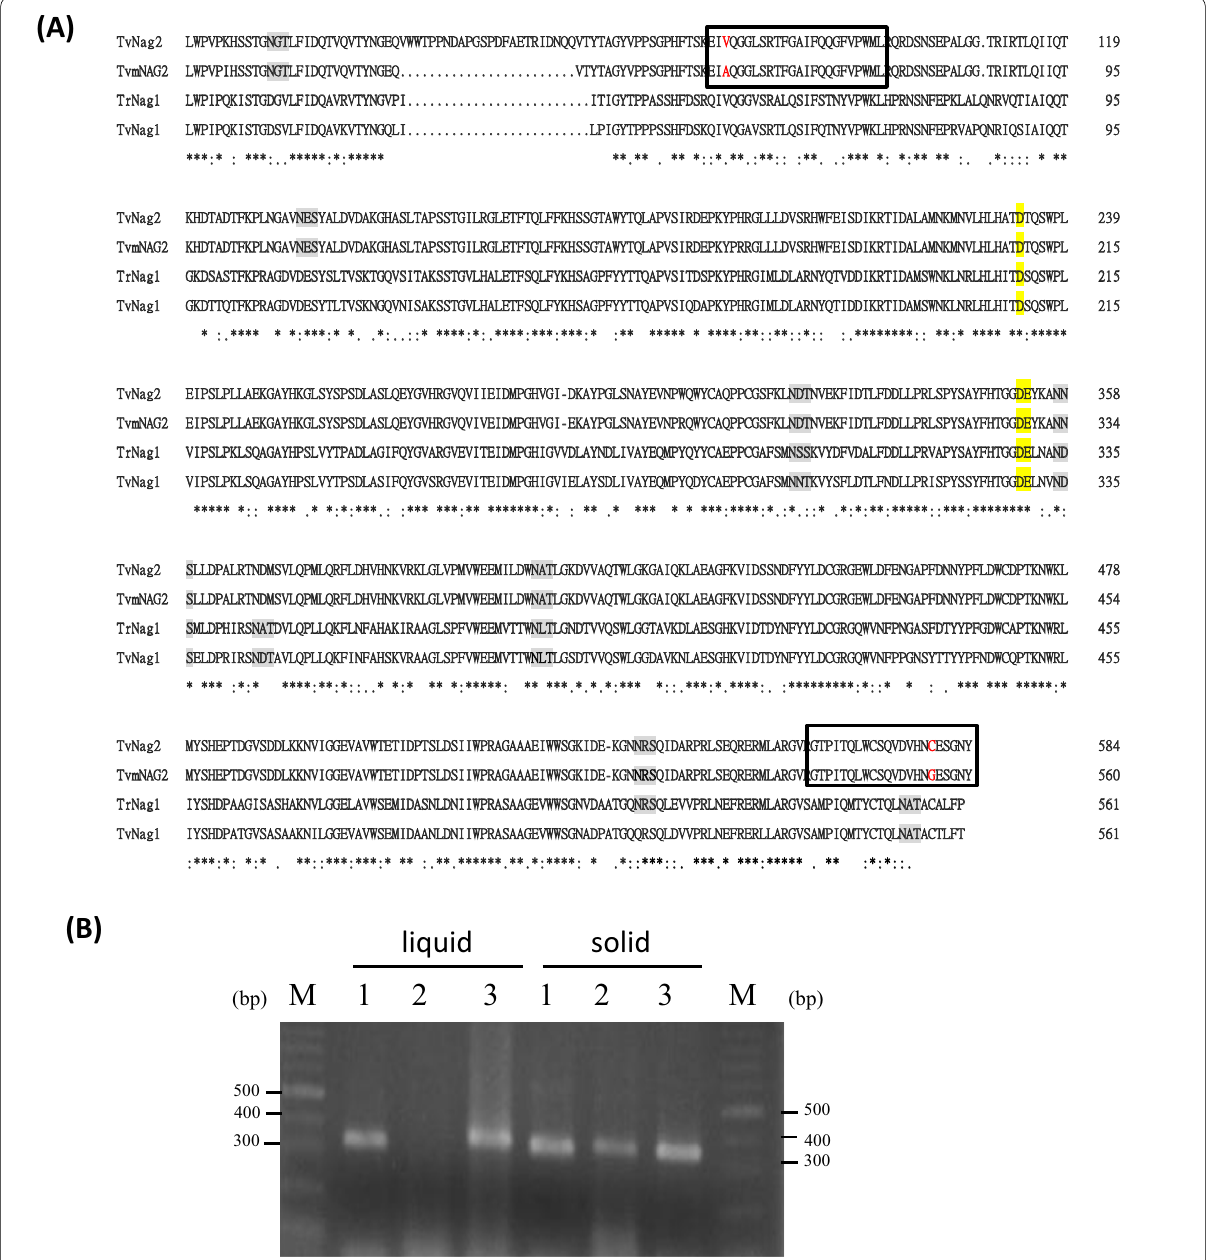
Fig. 10 Deduced protein sequence alignment of nag1 and nag2 , and expression of nag1 and TvmNAG2 . A The deduced TvmNAG2, TvNag1, TvNag2 and TrNag sequences from T. virens strain mango, T. virens strain Gv29‑8, T. virens strain Gv29‑8 and T. reesei strain QM6a were aligned (accession number of OL456168, XM_014095216, XM_014099474, and XM_006963001, respectively). The conserved E (Glu) and D (Asp) in active site were highlight. Two amino acids of deduced TvmNAG2 marked in red were different from the amino acids within the matched TvNag2 peptides of MALDI/MS analyses. Such peptides were boxed. Putative glycosylated sites, NxS/T were shaded. B The expression of TvmNAG2 and nag1 from T. virens strain mango in liquid and solid cultures were analyzed by RT‑PCR. Line 1 and 4, actin ; line 2 and 5, nag1 ; line 3 and 6.